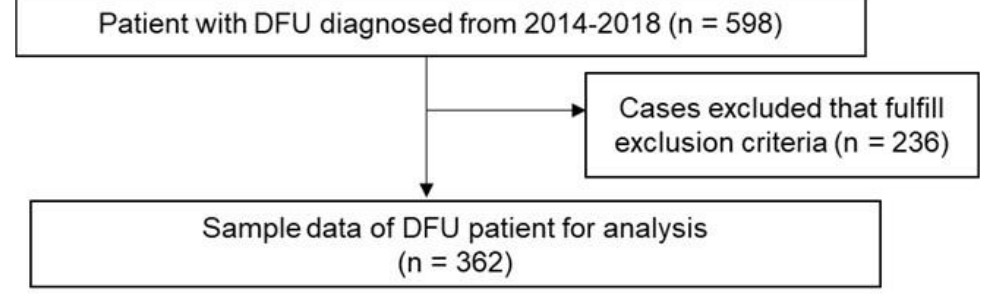
Figure 1. Flow Chart of Sample.